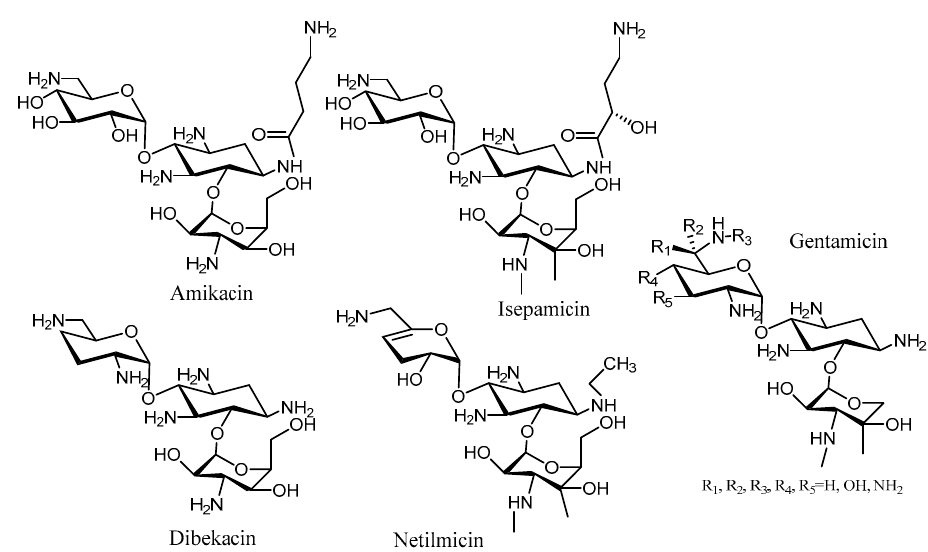
Figure 3. Structure of kanamycin class of aminoglycosides.